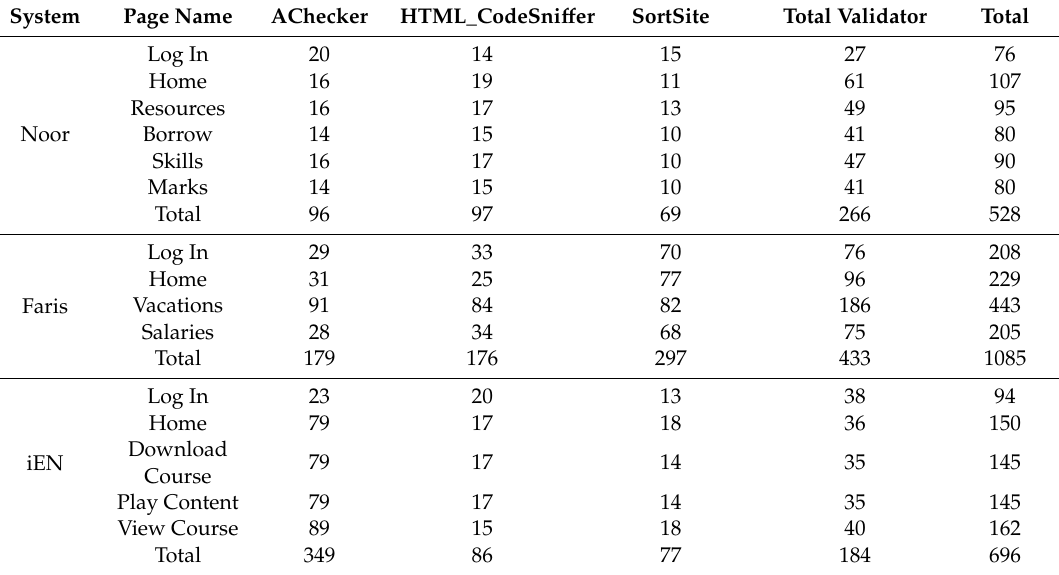
Table 8. Total number of errors based on the pages